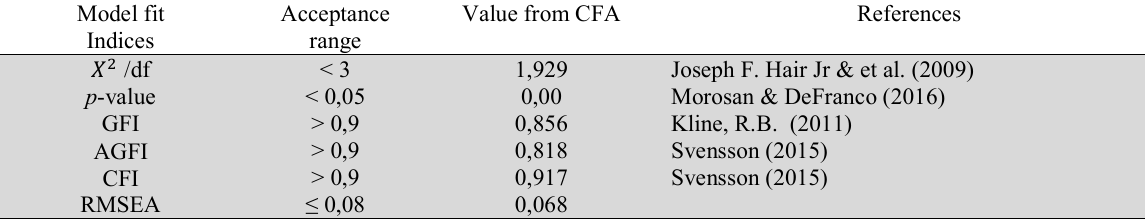
CFA analysis of suitability level of the